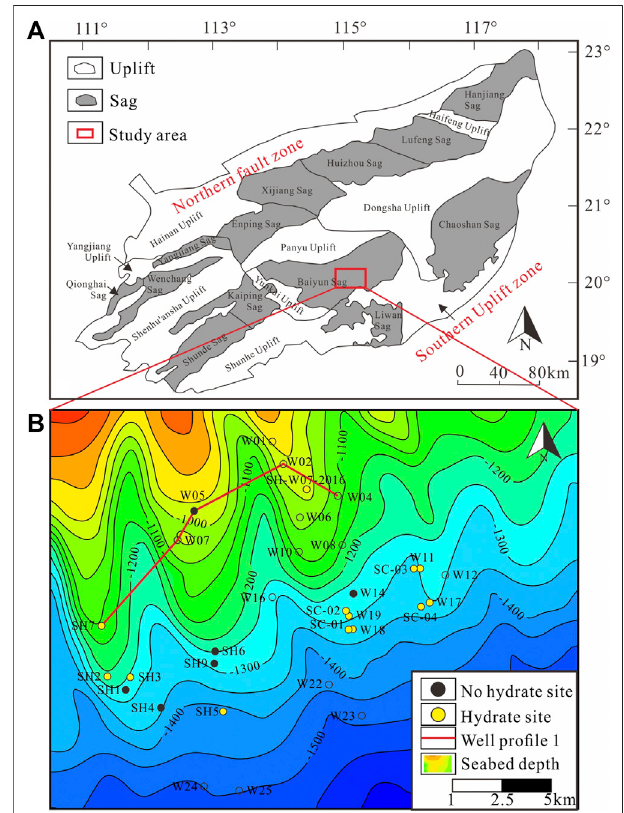
FIGURE 1 | The geographical location and well location characteristics of the Shenhu area: (A) Tectonic unit of the Pearl River Mouth Basin; (B) The location and pro fi le of the coring well in this study (the data came from Liang et al., 2014; Zhang et al.,